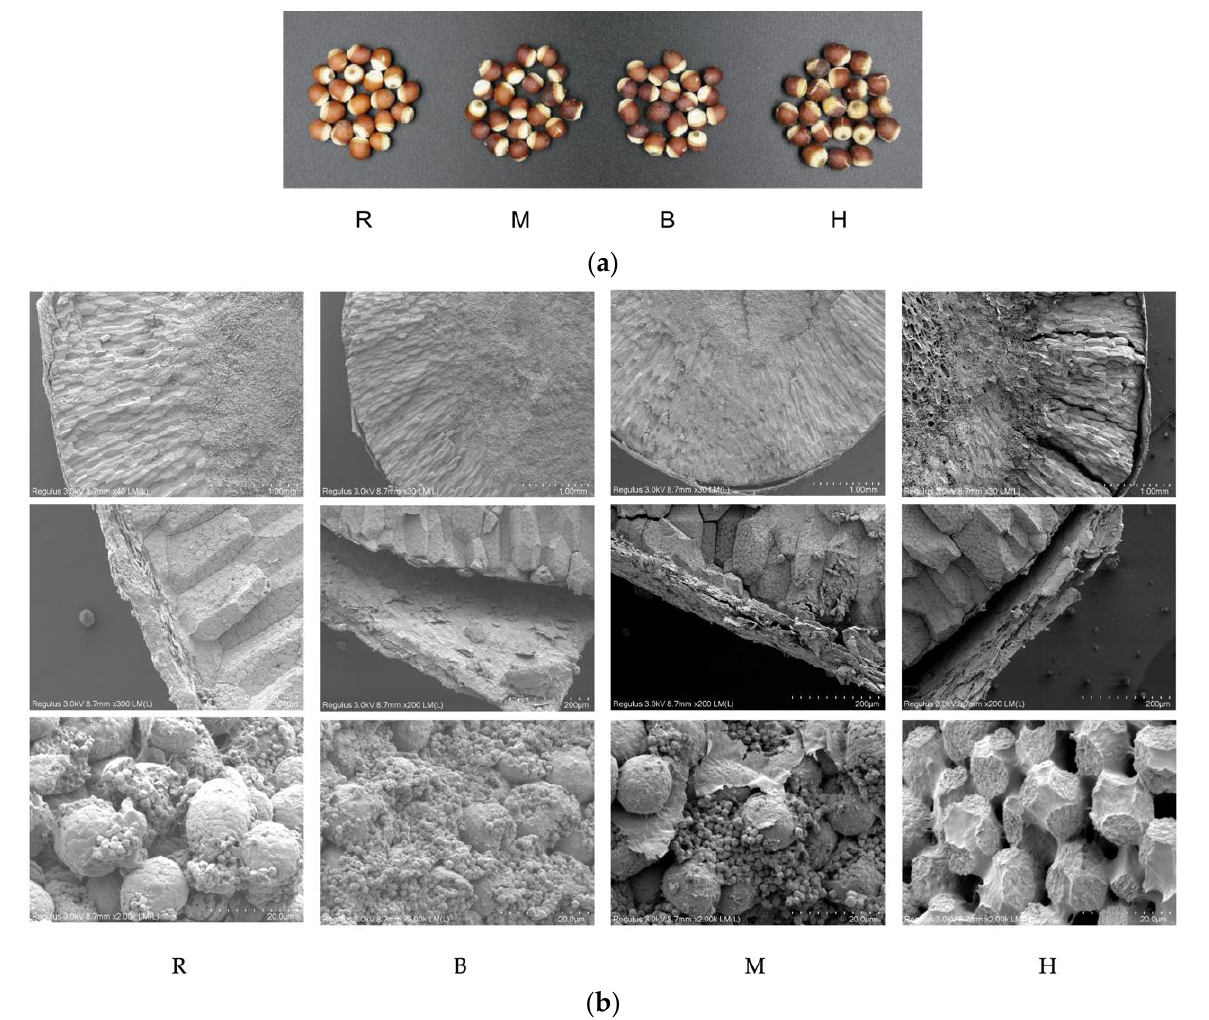
Figure 1. Surface morphology and microstructure of Euryale ferox seed (EFS). ( a ) Image of EFS after different thermal processing. ( b ) Scanning electron microscopy. R: Raw; M: Microwave; B: Baking; H: Industrial infrared heating-assisted fluidized bed (IHFH).